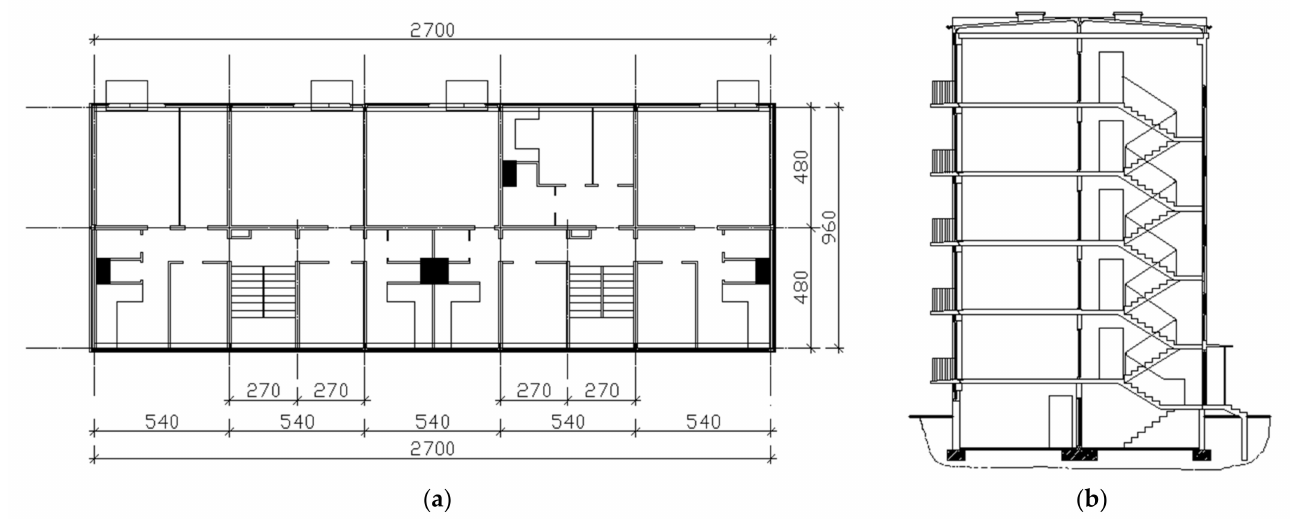
Figure 1. A typical floor plan and cross-section of the V-storey, two staircases building in OWT-67 system. Dimensions are in cm. ( a ) A floor plan repetitive storey; ( b ) Cross-section through the communication and the balcony slab (author’s archive, according to [43]).